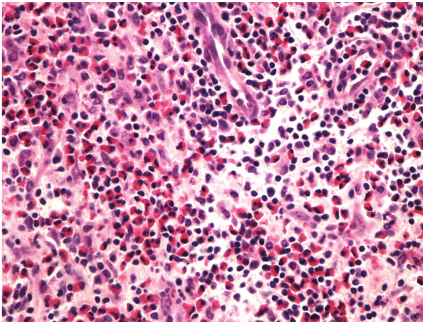
Figure 2: Activated lymphatic nodule, fibrosis (immunohistochem- ical staining with CD20 (B-cells), microscopic magnification of × 20).